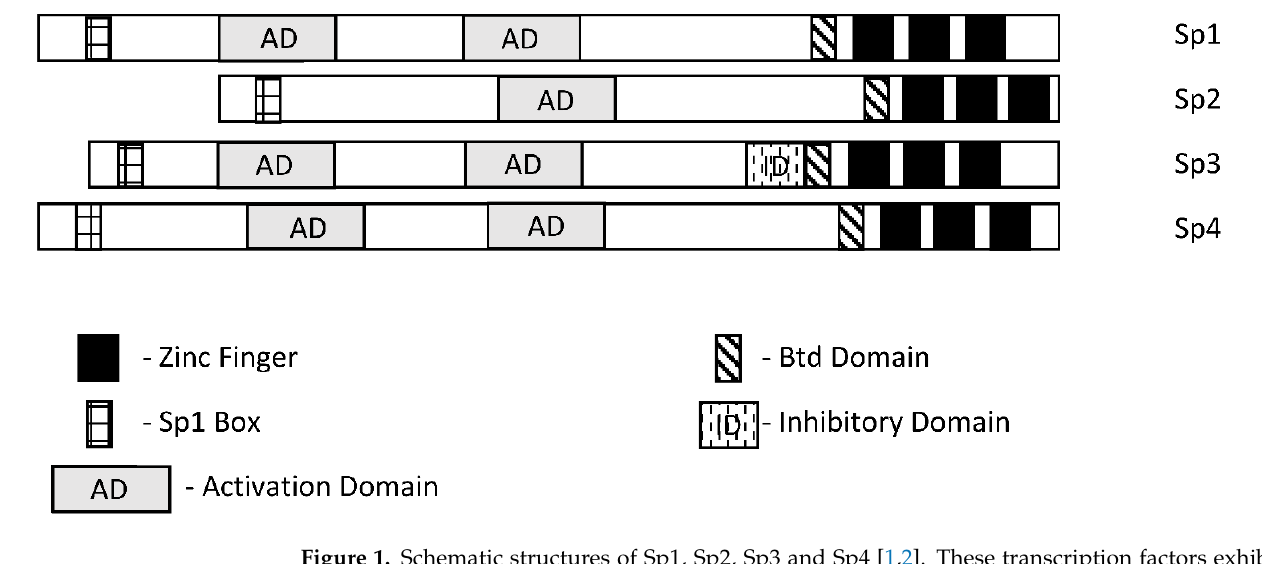
Figure 1. Schematic structures of Sp1, Sp2, Sp3 and Sp4 [1,2]. These transcription factors exhibit several common structural features; however, Sp3 expresses an inhibitory domain that results in gene-specific decreased expression in some cell lines.